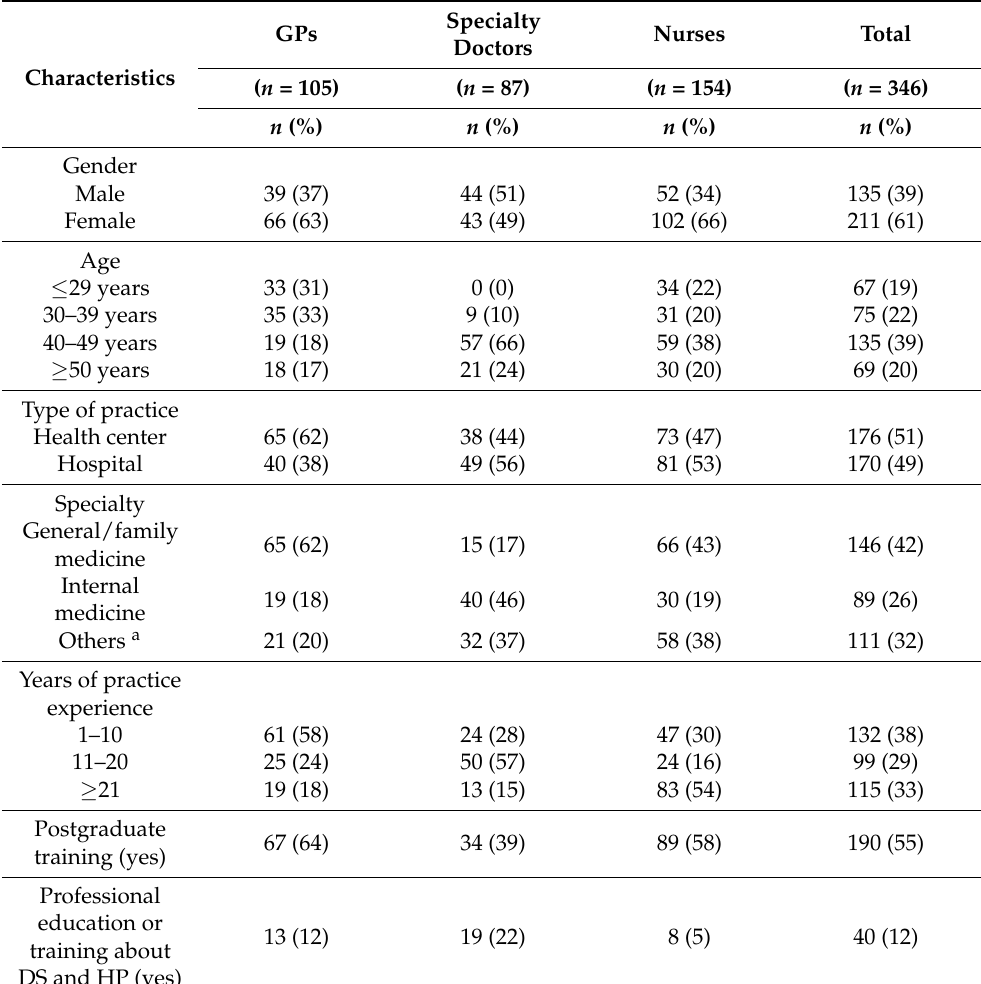
Table 1. Demographic and professional characteristics of